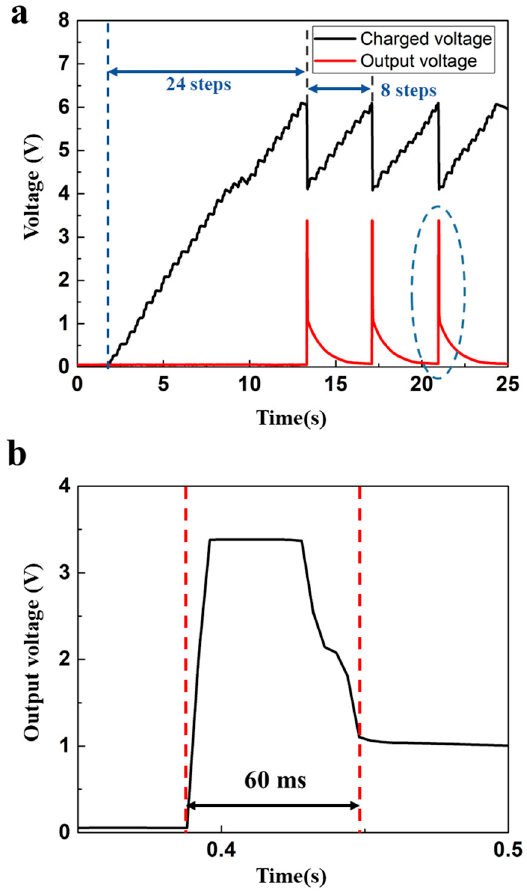
Figure 8. ( a ) Charged voltage in the capacitor and output voltage, ( b ) Time needed to transfer a